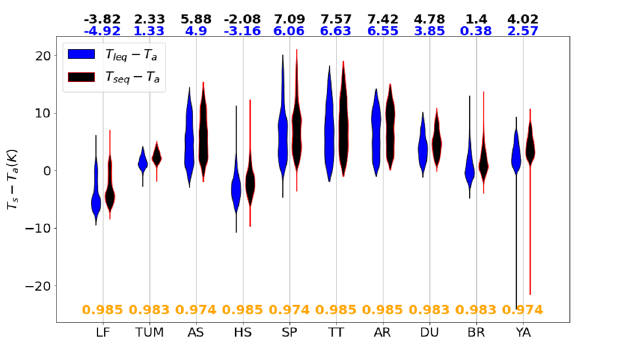
Figure 2. Yearly distributions of half-hourly surface-to-air temperature differences ( (cid:31) T = T s − T a ) for a representative year at each site. LST was calculated using the short equation [Eq. (10)] or long equation [Eq. (6)] with landscape-scale emissivity ( ε MODIS ). The median values of (cid:31) T are shown at the top of the plot and the ε MODIS values used for the T s retrieval are shown at the bottom in orange. See Table 2 for site abbreviations. The shapes of the violin represent the distributions of (cid:31) T